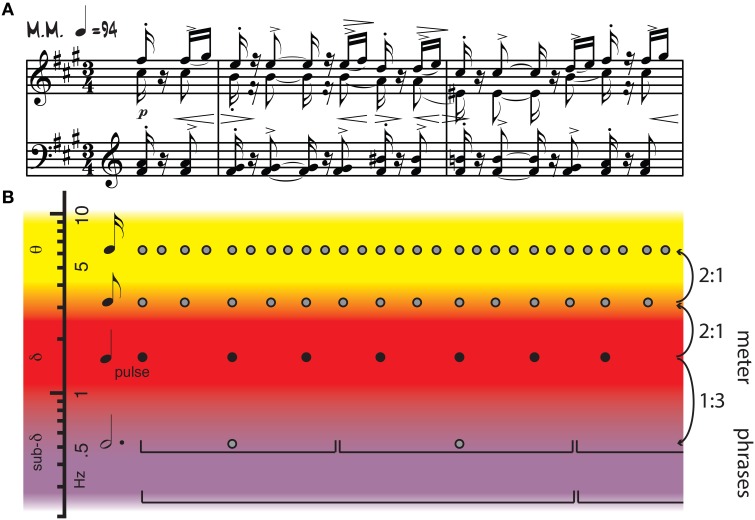
(A) Piano score of Isaac Albeniz's Iberia II, Triana. (B) Annotation showing pulse (black dots), metrical structure (all dots), and phrasing (brackets). Pulse frequencies overlap with cortical oscillations in the delta range, while other metrical frequencies extend into theta and sub-delta ranges. Frequency relationships among metrical levels include harmonics, subharmonics, and other integer ratios. Adapted from Large (2014).